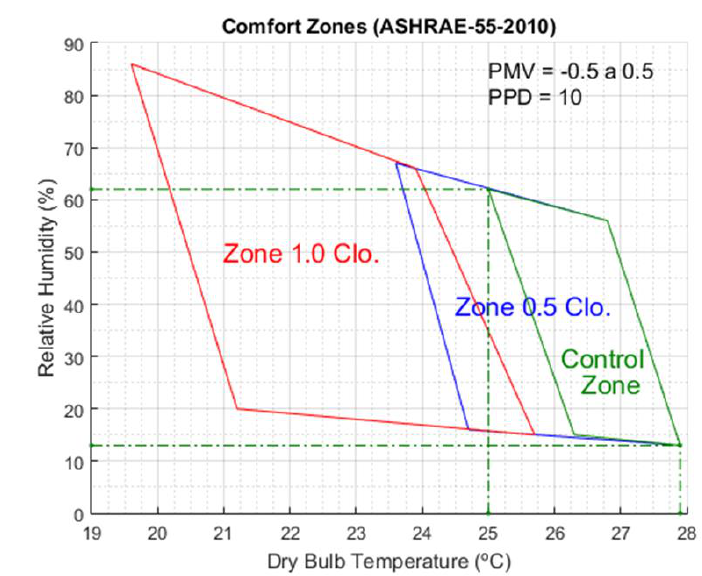
Figure 7. Control zone of the proposed control system.